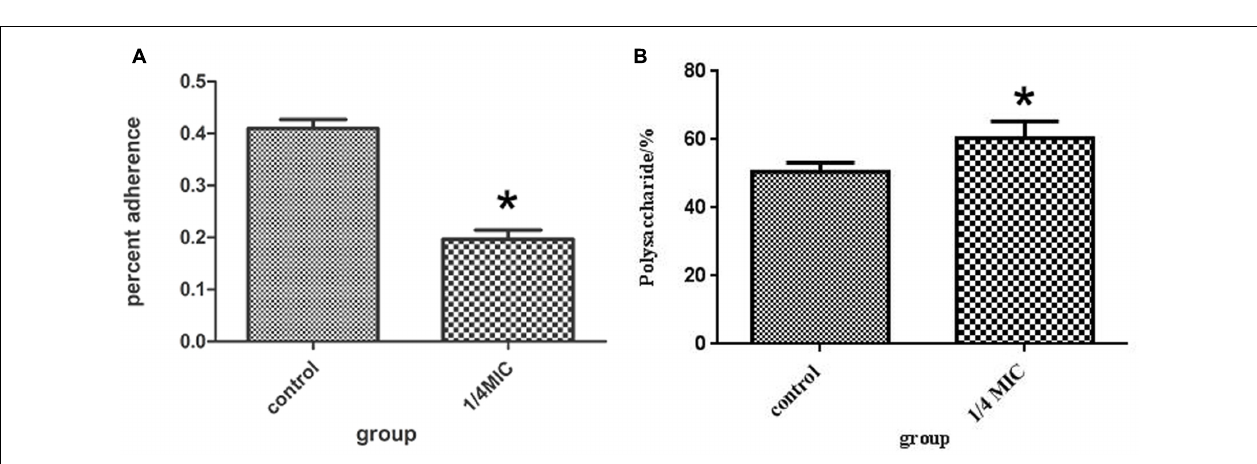
FIGURE 4 | Effect of 1/4 MIC (0.0781 mg/ml) rutin on S. suis adhesion (A) . Effect of 1/4 MIC (0.0781 mg/ml) rutin on the polysaccharides content of S. suis (B) . The data are expressed as means ± standard deviations. Asterisk indicates statistically significant difference of treatment versus untreated culture ( ∗ p <